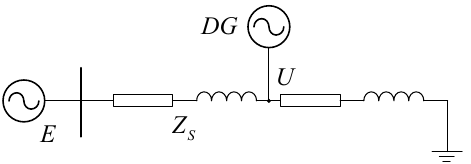
Figure 1. Thevenin equivalent circuit of the distributed generation (DG) access point.